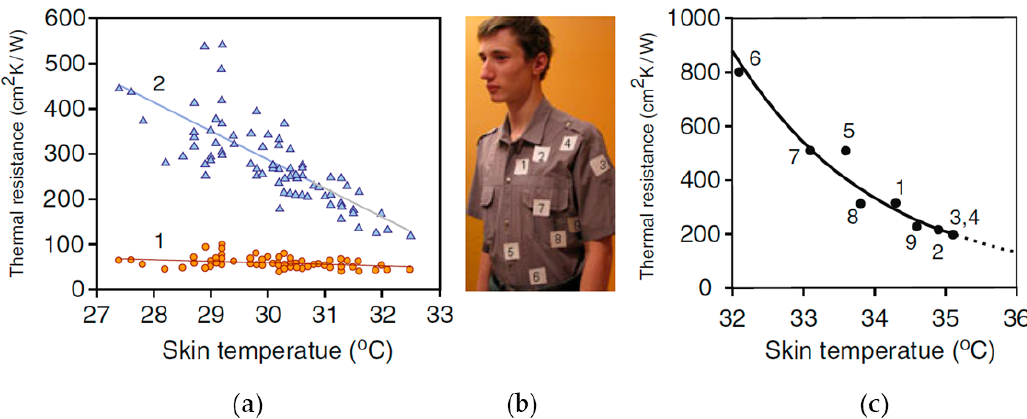
Figure 20. ( a ) Estimated thermal resistance per square centimetre of the skin, measured at 22.7 ± 0.5 ◦ C on the wrists of 77 people under the attached TEG: (1) is the thermal resistance between the body core and arterial blood in the wrist, (2) is the thermal resistance between the arterial blood and TEG. ( b ) Nine locations where the thermal resistance of the human body has been measured; ( c ) the thermal resistance of the human body at 23 ◦ C depending on its location on the trunk [112]. Table 4. Thermal resistance measurements measured at various body locations.